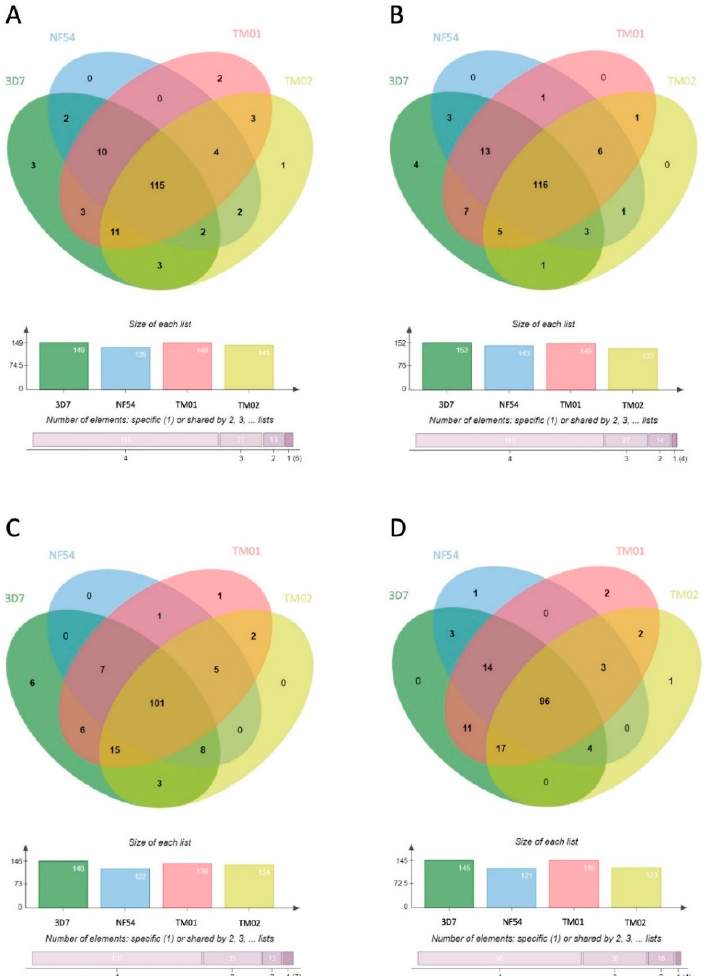
Figure 5. Venn diagrams showing the P. falciparum proteins differentially expressed in each type of Pf -EVs from 4 P. falciparum strains (3D7, NF54, TM01, and TM02). ( A ) MV-E, n = 161; ( B ) MV-L, n = 161; ( C ) Exo-E, n = 155; ( D ) Exo-L, n = 154. The column graphs present the number of proteins from each strain of P. falciparum , and the bar graphs indicate the numbers of proteins shared by P. falciparum